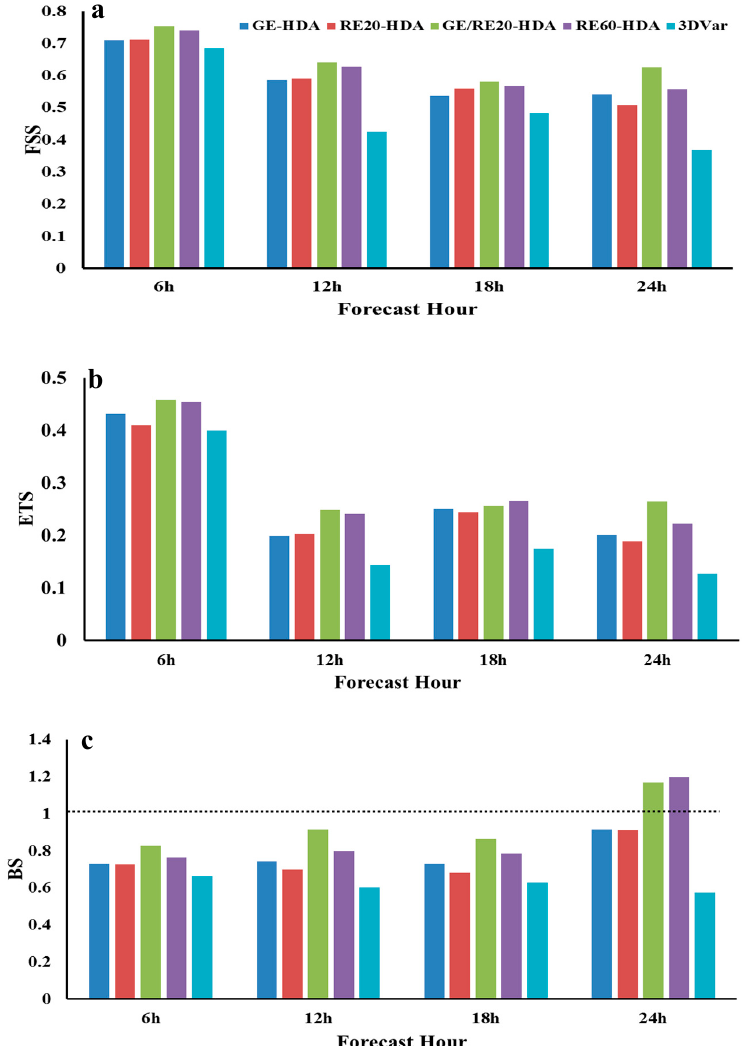
Figure 10. The rainfall forecasting scores with a threshold of 12.5 mm / 6 h as a function of forecast leading time for the ( a ) Fraction Skill Score (FSS), ( b ) Equitable Threat Score (ETS), and ( c ) Bias Score (BS).